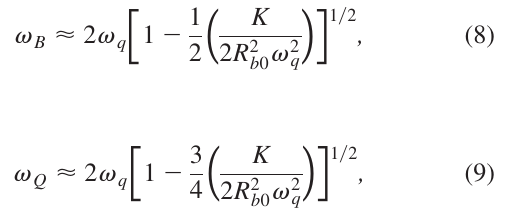
FIG. 9. WARP 2D PIC simulation results for the beam responses to (a) colored noise with (cid:5) ac ¼ 5 T and (cid:1) mismatch introduced by the incorrect (1.5 times stronger in this case) focusing field strength for one FODO lattice period, and (c) the combination of colored noise and beam mismatch. The mean radius ½ a ð t Þ b ð t Þ(cid:7) 1 = 2 (top), the on-axis density n ð 0 Þ (middle), and the mean transverse emittance ½ (cid:2) x (cid:2) y (cid:7) 1 = 2 (bottom) are normalized to their initial values, respectively, and perturbation starts at t ¼ 0 ms . For a fair comparison, the same colored noise sample has been applied to cases (a) and